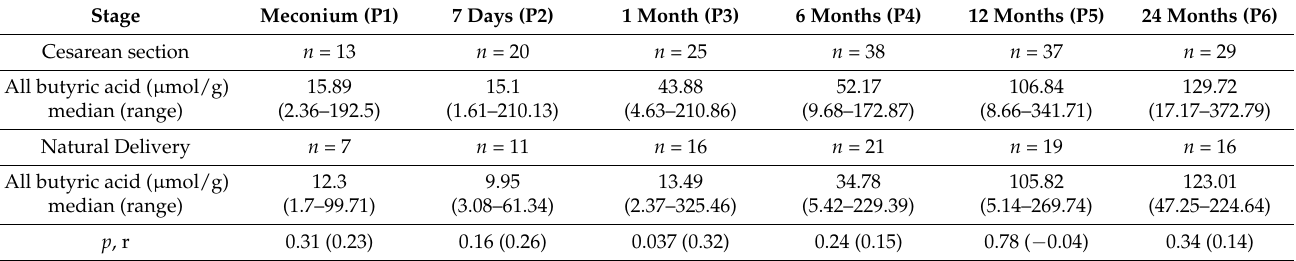
Table 5. Effects of delivery mode on fecal butyric acid concentrations.